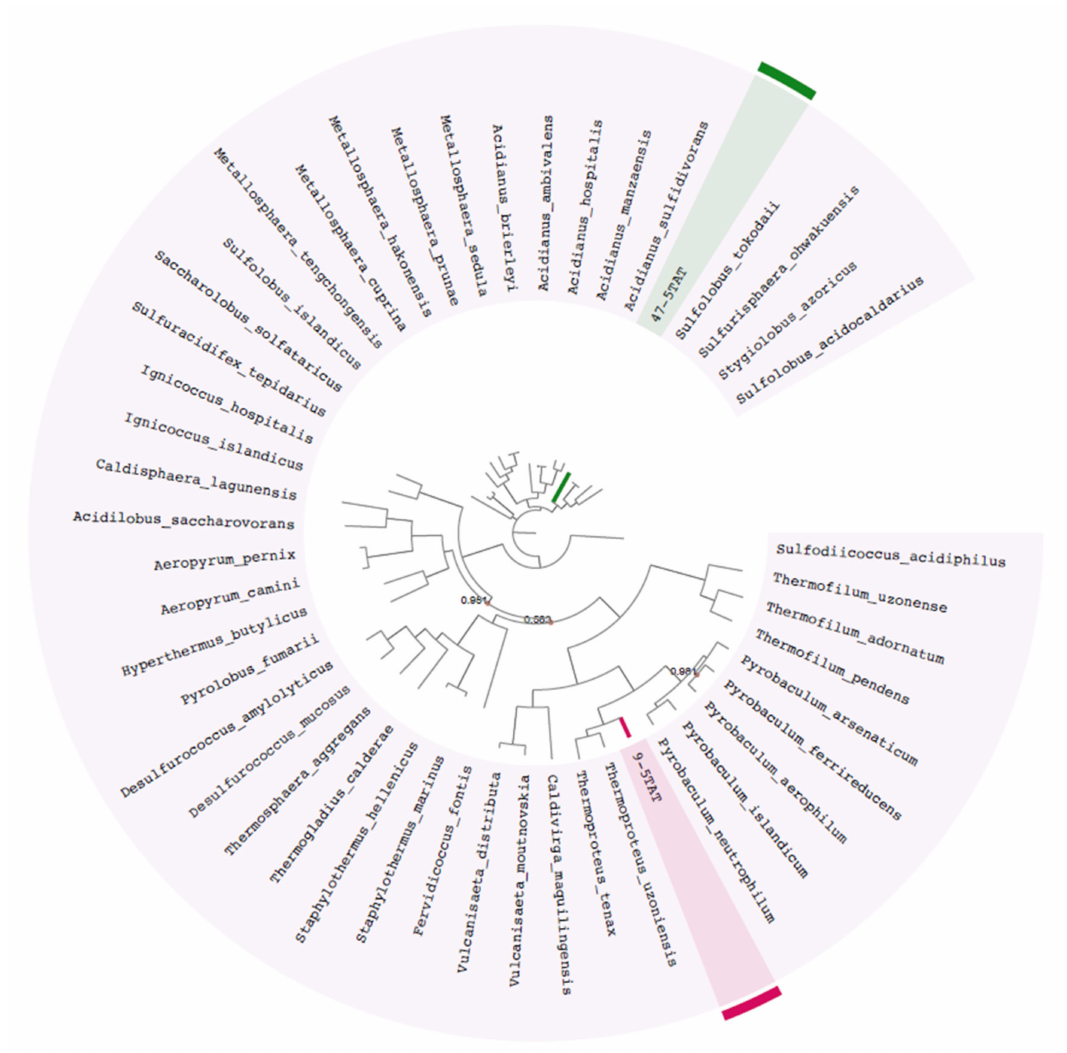
Figure 1. Phylogenetic tree for MAGs. The maximum-likelihood tree was constructed from a concatenated alignment of 76 conserved single-copy marker proteins which were identified in 46 representative genomes of the phylum Crenarchaeota, bootstrap values <100 are displayed on the internal branches. MAG 9-5TAT is highlighted in green and MAG 47-5TAT is highlighted in